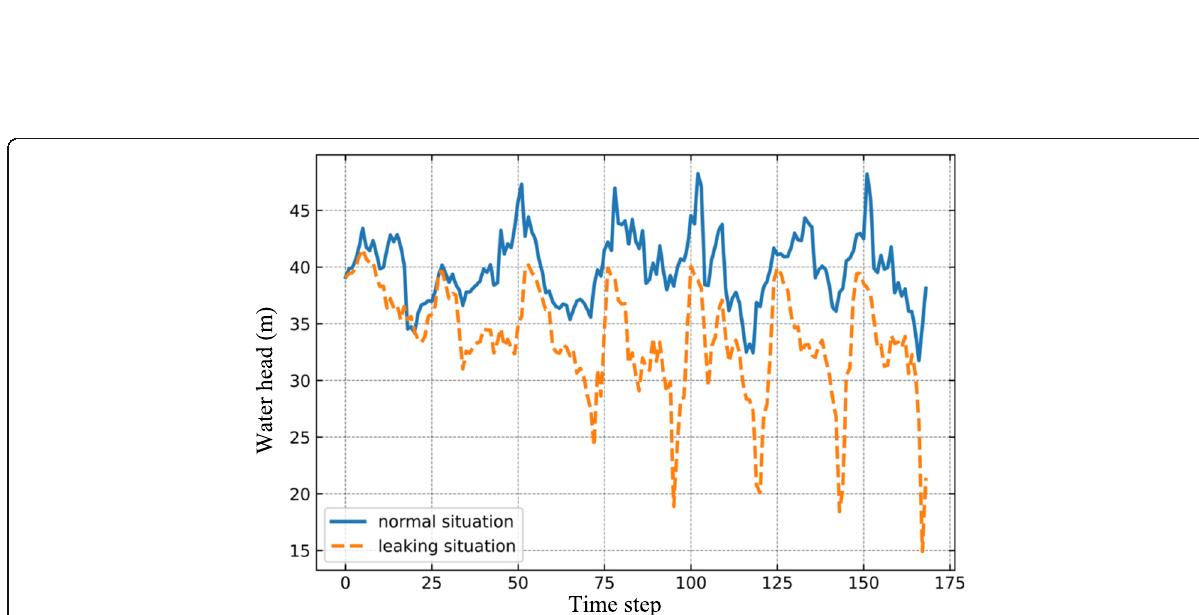
Fig. 18 Water pressure (water head) at ‘ J9 ’ with and without leaking